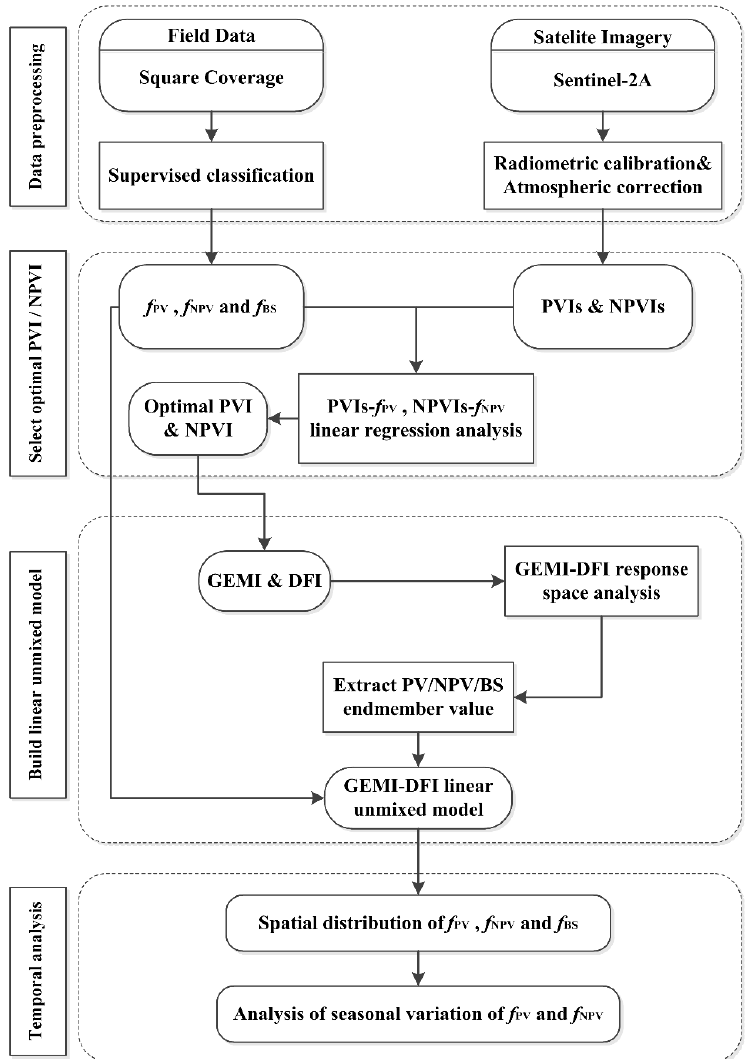
Figure 3. A methodology flowchart.